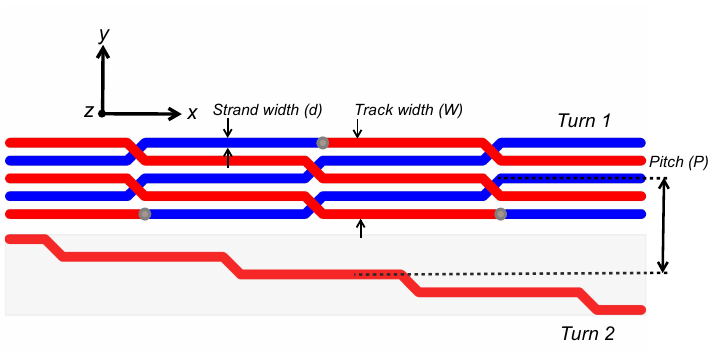
Figure 4. Two-layer Litz style PCB tracks with top layer in red, bottom layer in blue ( Upper track ) and an extracted interleaving strand ( Lower track